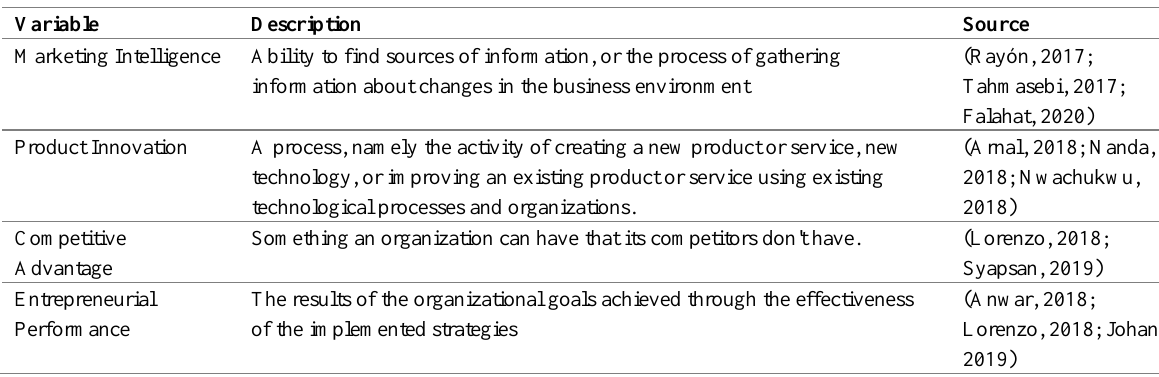
Table 1: Operational Variables